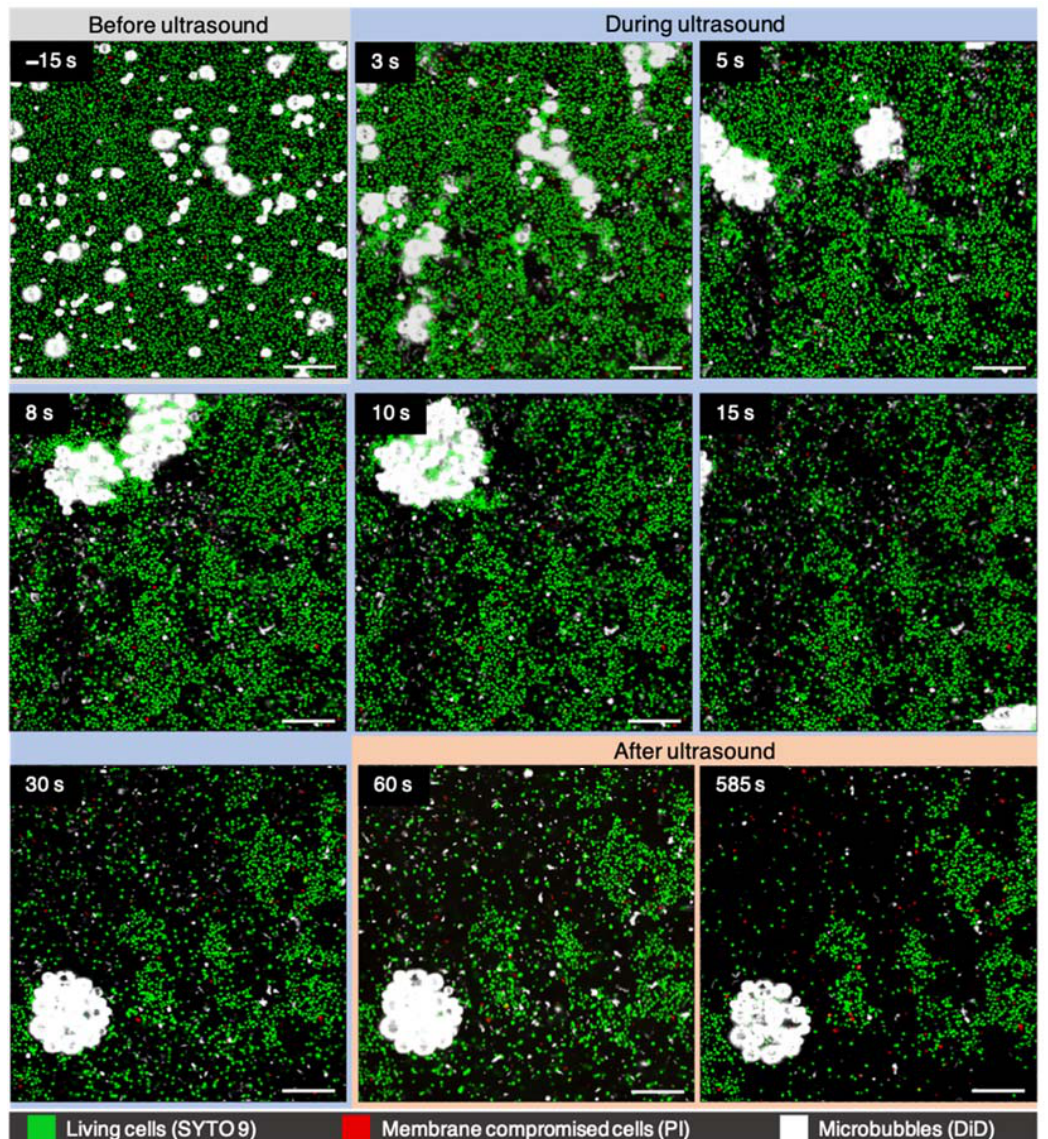
Figure 3. Sonobactericide of S. aureus biofilm at ultrasound settings of 2 MHz, 400 kPa, 100 cycles, PRF 1 Hz, 30 s. Selected confocal microscopy frames during a 10 min time-lapse recording of all three channels together. Scale bars represent 20 μ m.